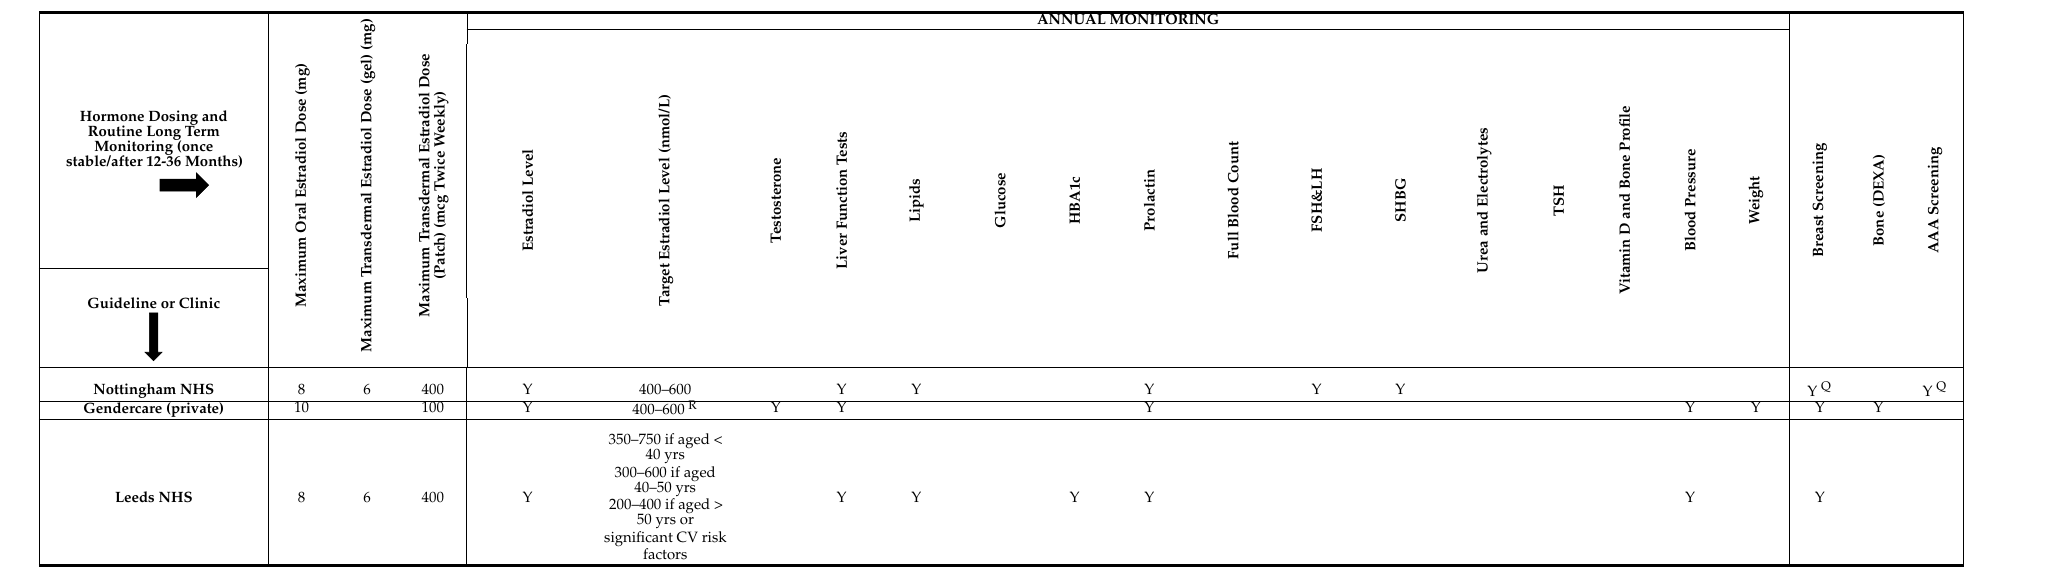
Key: Empty cell: no specific advice given; HBA1c, Glycated Haemoglobin; FSH&LH, Follicle Stimulating Hormone and Luteinizing hormone; SHBG, Sex hormone binding globulin; TSH, Thyroid Stimulating Hormone; A ,”strong recommendations”; B , “level for premenopausal females (100 to 200 pg/mL)”; D , If on spironolactone; E , Consider screening at baseline. In individuals at low risk, screen at 60 years of age or if non compliant with hormone therapy; F , Unless prolonged periods without sex hormones or additional risk factors; G , Every 6 months; H , Every 3 months; J , Annually to document recovery after being on puberty suppression as required; K , Yearly or as required; L consider to “fine tune hormone regimes”; M , Dependent on age and length of exposure to estradiol; N , from age 65 years on (earlier if risk factors); P , advises if transwomen continue estradiol over 70 years of age they should “continue” receiving breast screening, although screening for younger transwomen is not specified; Q , screening as